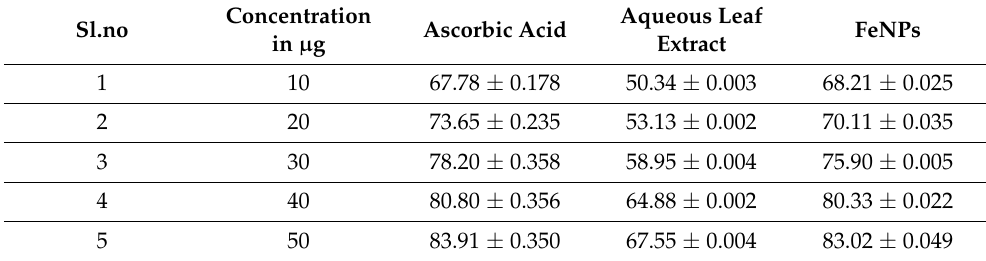
Table 4. DPPH assay of aqueous leaf extract of V. leucoxylon and its synthesized iron nanoparticles.